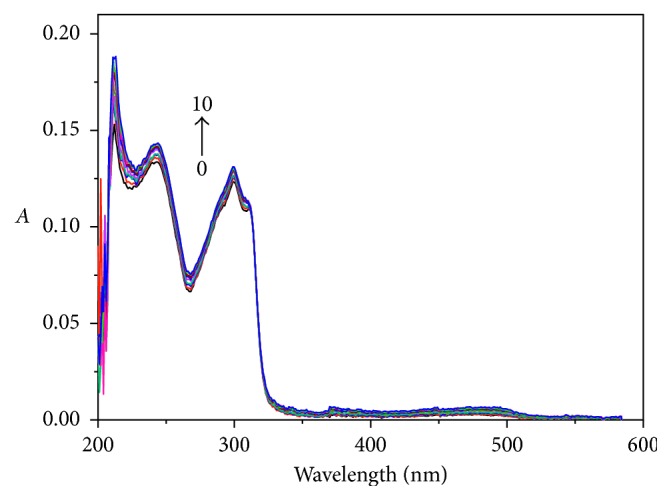
Influence of phosphate on the UV-Vis spectra of Cu-bipy (pH 7.40). c(Cu-bipy) = 1.0 × 10−5 mol·L−1; c(Na2HPO4) = 0.00, 0.33, 0.67, 1.00, 1.33, 1.67, 2.00, 2.33, 2.67, 3.00, 3.33, 3.67, 4.00, 4.33, 4.67, and 5.00 × 10−5 mol·L−1, respectively.